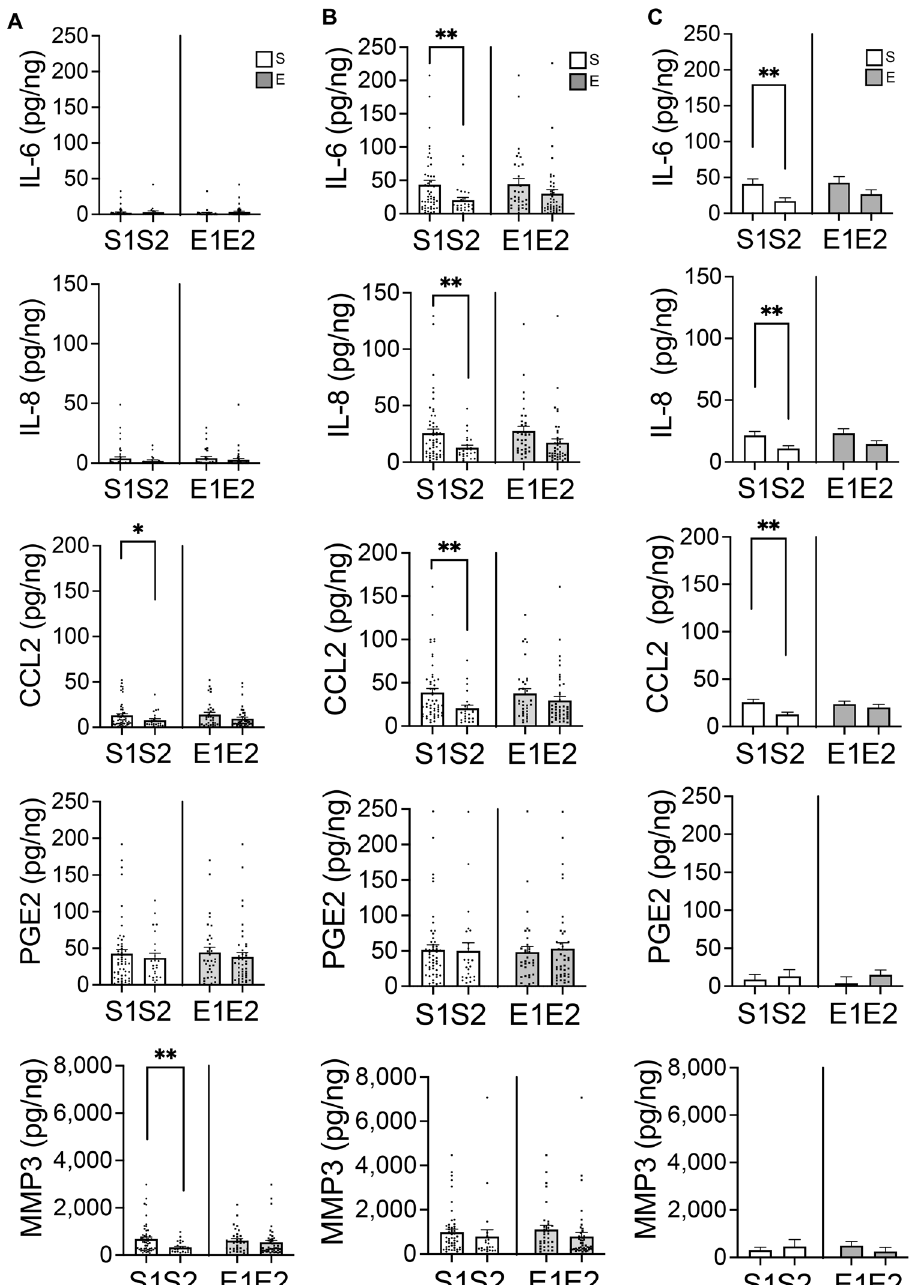
Figure 5. Ultrasound grade and response to IL-1ß stimulation. The sample sizes for each group were: S1(n = 53), S2(n = 24), E1(n = 33), E2(n = 44). ( A ) Protein concentration in the supernatant before addition of IL-1ß. ( B ) Protein concentration in the supernatant after addition of IL-1ß. ( C ) Change in protein concentration in supernatant. Bars are show the mean ± SEM. * p < 0.05, ** p < 0.01, *** p <